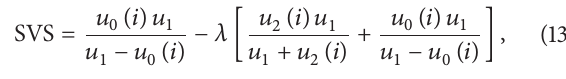
Figure 16: SVS versus split with triangular fundamental diagram; = 180 veh/km, 𝑞 𝑘 𝑗 12.5 km/h.